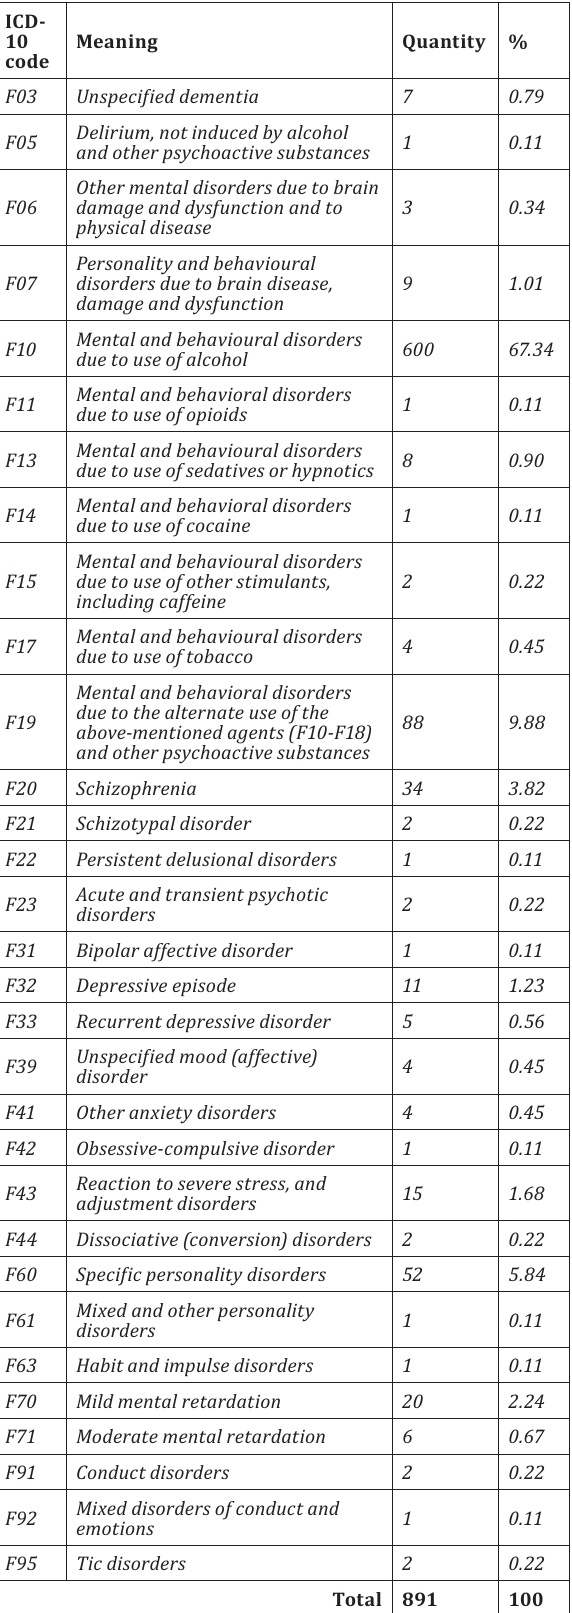
Table 3. List of ICD-10 codes for F00-F99 category in homeless patients admitted to ED